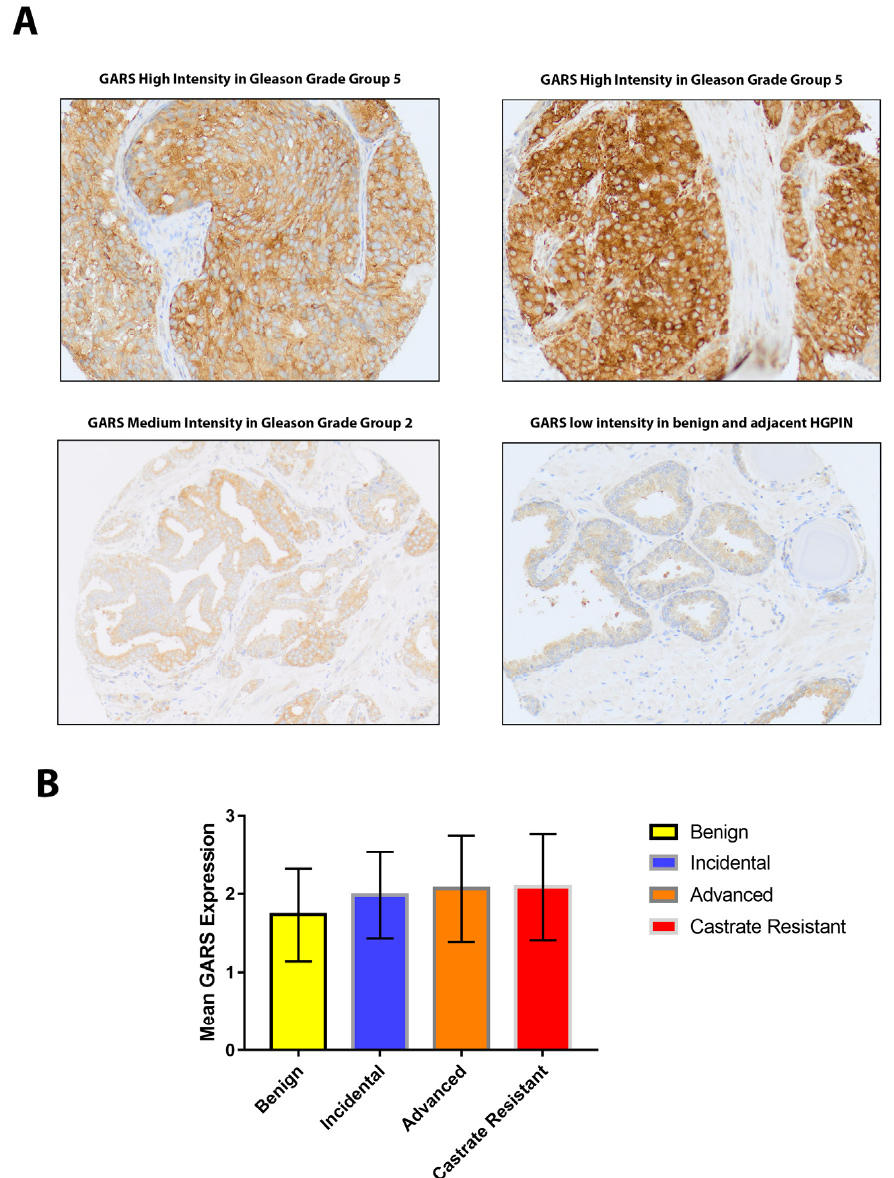
Figure 1. GARS protein expression in prostate tissue. ( A ) IHC staining of GARS showing low intensity in benign and adjacent HGPIN (high grade prostatic intraepithelial neoplasia) (bottom right panel, 20 × magnification), medium intensity in prostate cancer Gleason grade Group 2 (top left panel, 20 × magnification), and high intensity in prostate cancer Gleason grade Group 5 (left and right bottom panel) (20 × magnification). ( B ) Box plot demonstrating mean expression of GARS in benign ( n = 44), incidental ( n = 60), advanced ( n = 69), and castrate-resistant PCa ( n = 63). Errors bars indicated ± standard deviation (SD). One-way ANOVA was performed, p = 0.626.